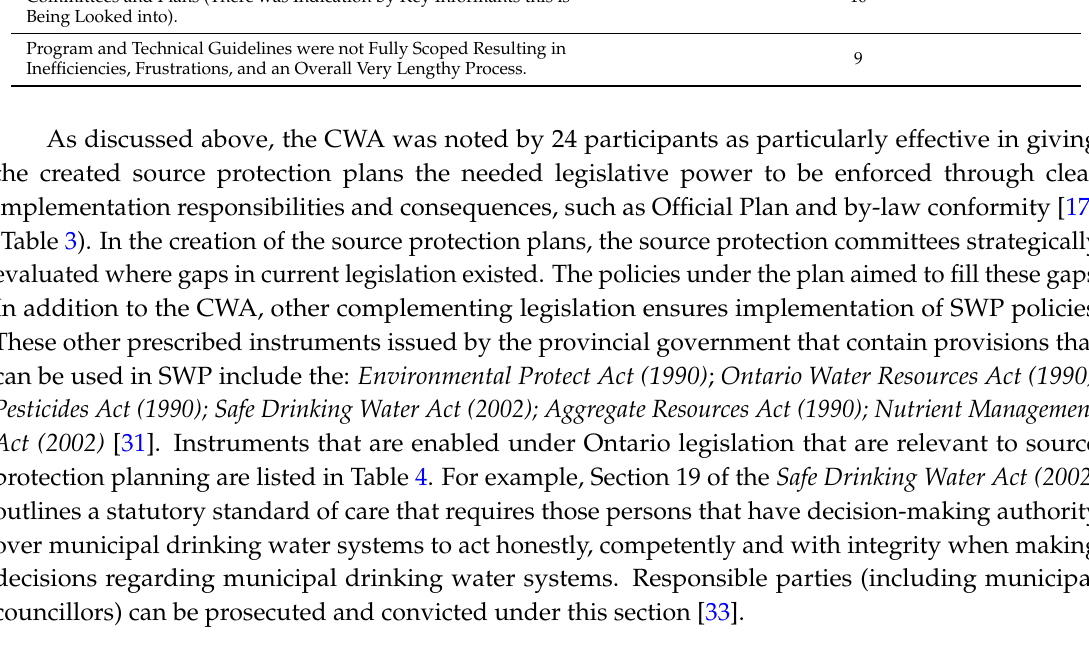
Table 4. Ontario Legislation Relevant to Source Protection Planning [31] (pp.